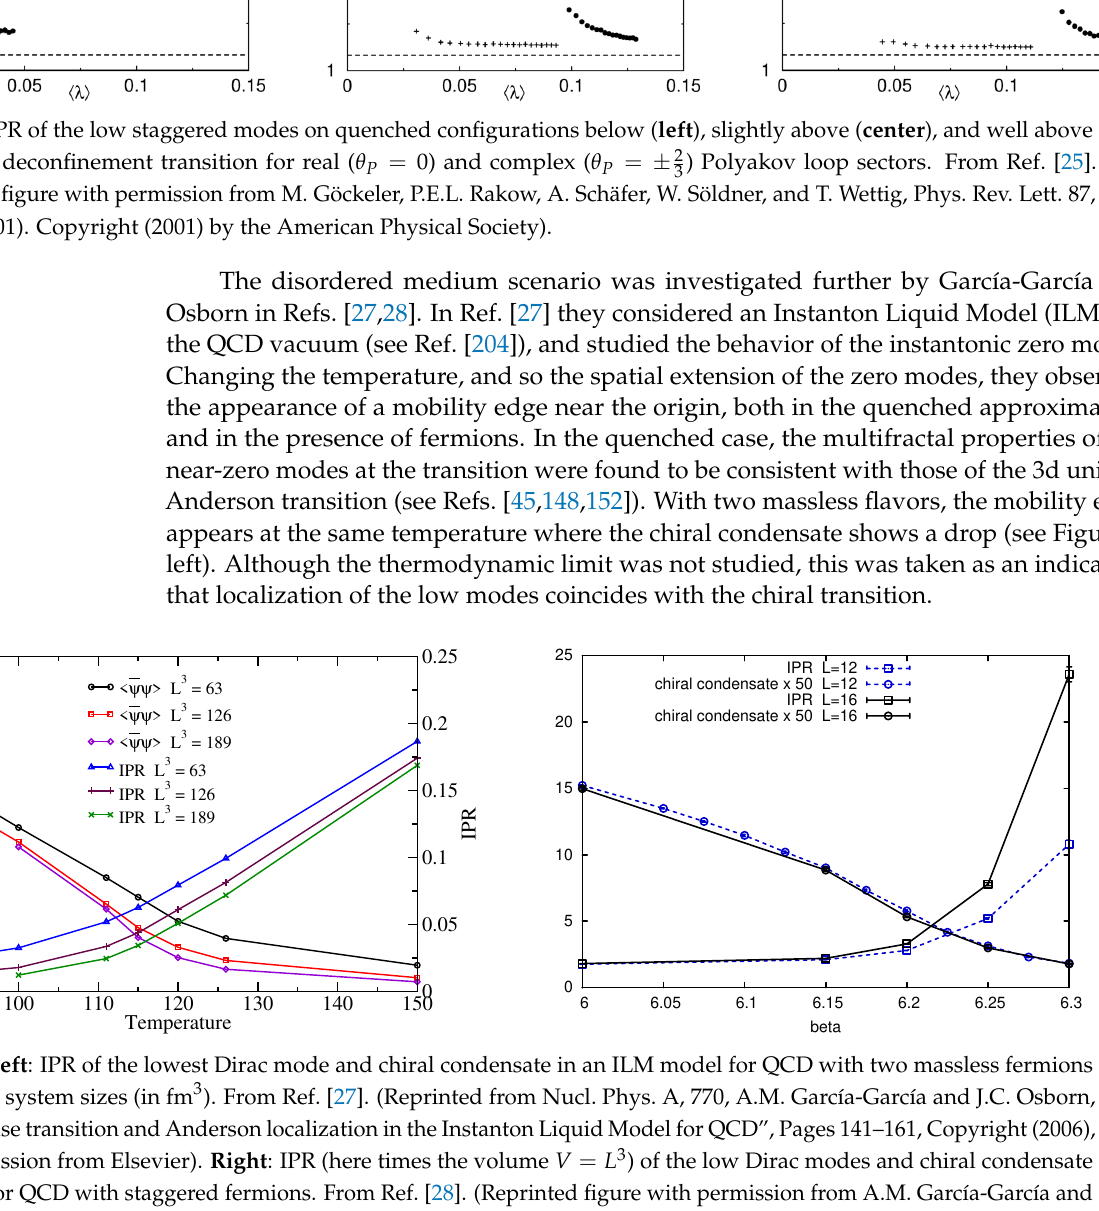
2 ) Polyakov loop sectors. From Ref. [25]. 3 ±